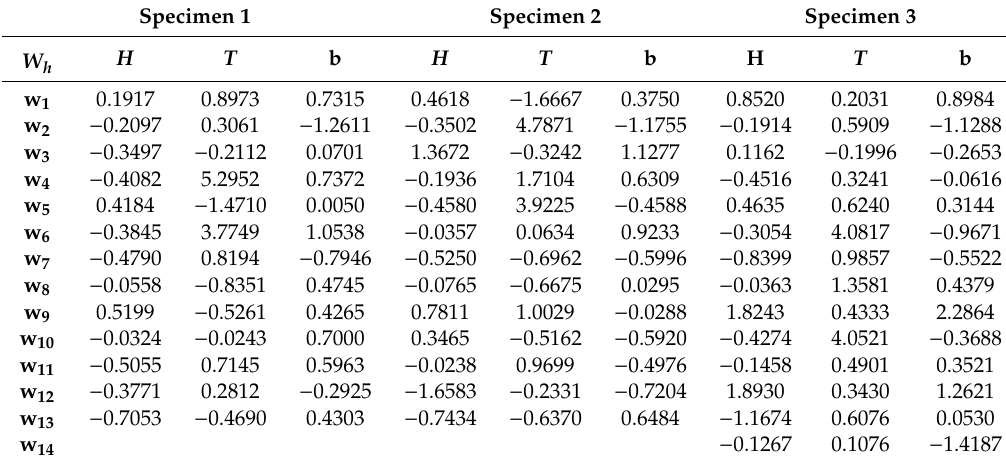
Table A4. Hidden synaptic weights of La-Fe-Co-Si ANNs.